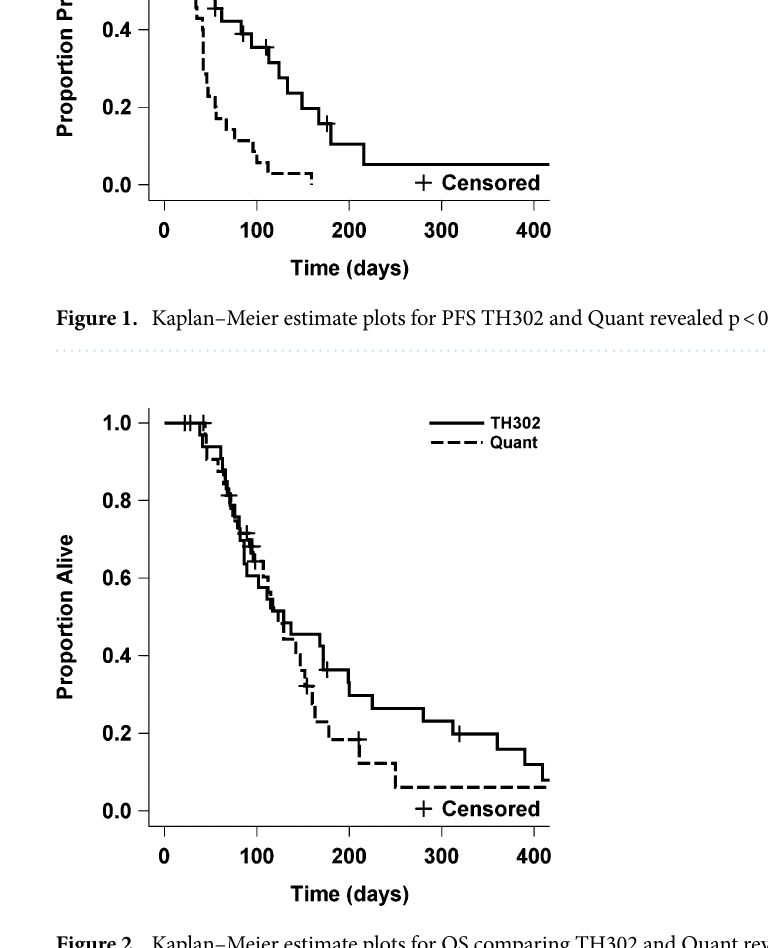
Figure 2. Kaplan–Meier estimate plots for OS comparing TH302 and Quant revealed p = 0.29 for